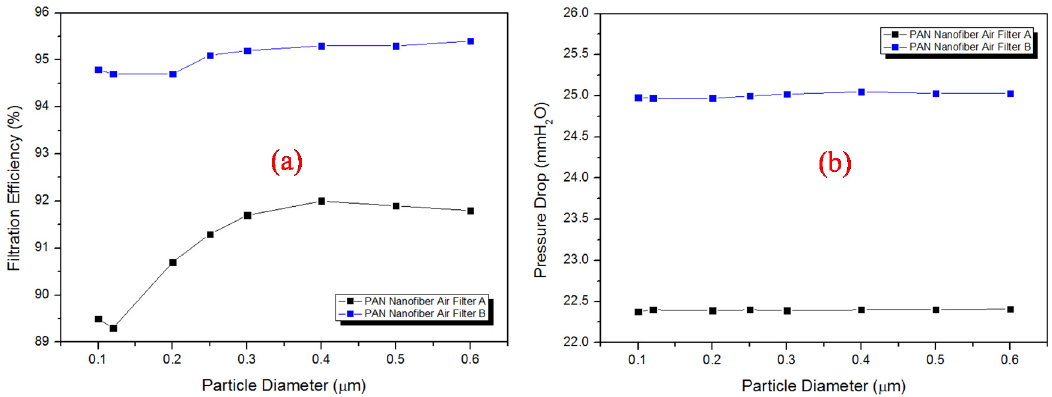
Figure 6. Diagrams of ( a ) the filtration efficiency of PAN nanofiber air filter A and B; and ( b ) the pressure drop of the PAN nanofiber air filter A and B.